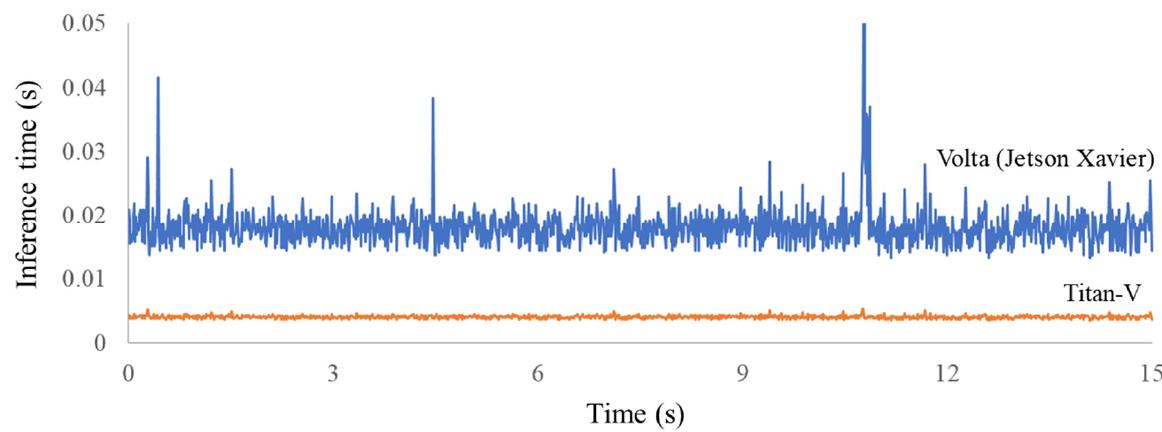
Table 2. Analysis of the estimated tomato maturity, by comparing the hue value with the maturity class.